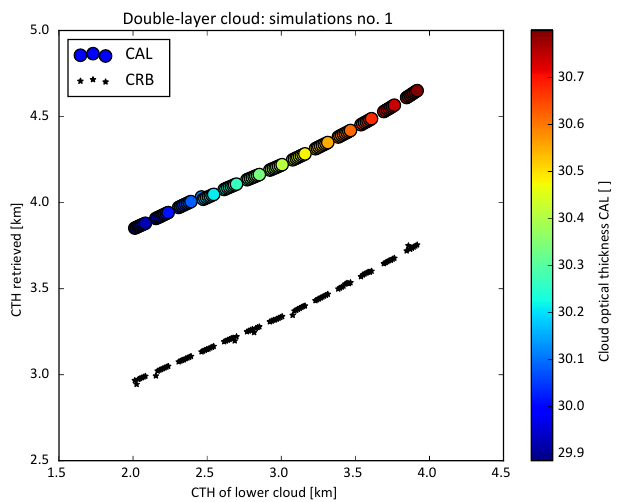
Figure 5. ROCINN-retrieved cloud properties for the first group of simulations (i.e. a low cloud with cloud optical thickness of 25, cloud geometrical thickness of 1km, and cloud top height in the range 2–4km, plus a mid-level cloud having cloud optical thickness of 10, cloud top height of 6km, and cloud geometrical thickness of